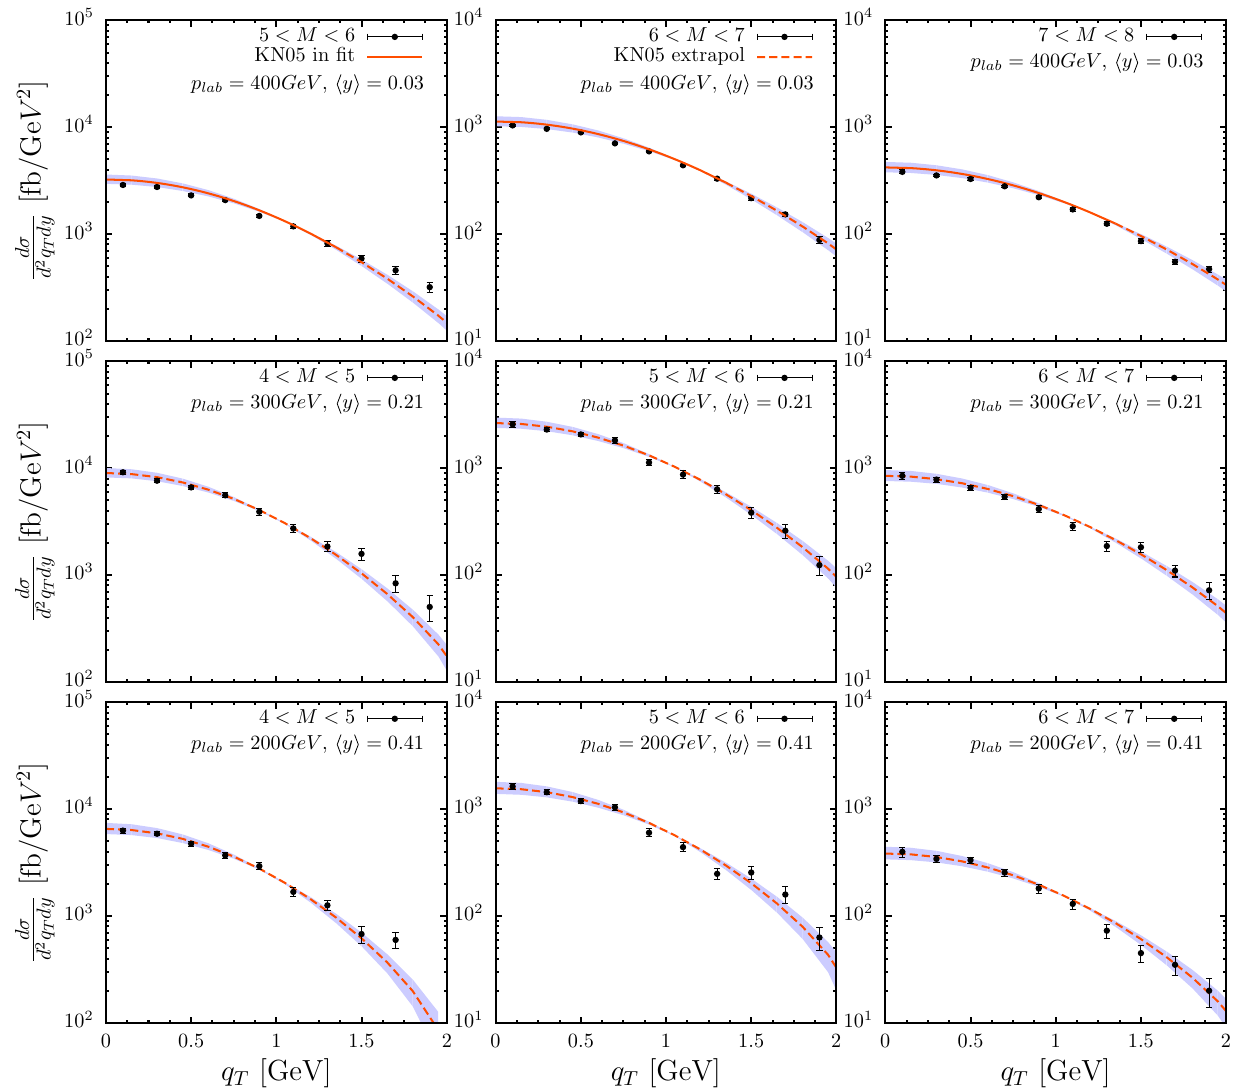
Fig. 1 Theoretical predictions obtained with the KN05 model [12] compared to DY transverse momentum spectra in pA collisions [37] in bins of the invariant mass of the pair, M , expressed in GeV, for differ- ent incident beam energies and DY pairs rapidities. Solid lines indicate